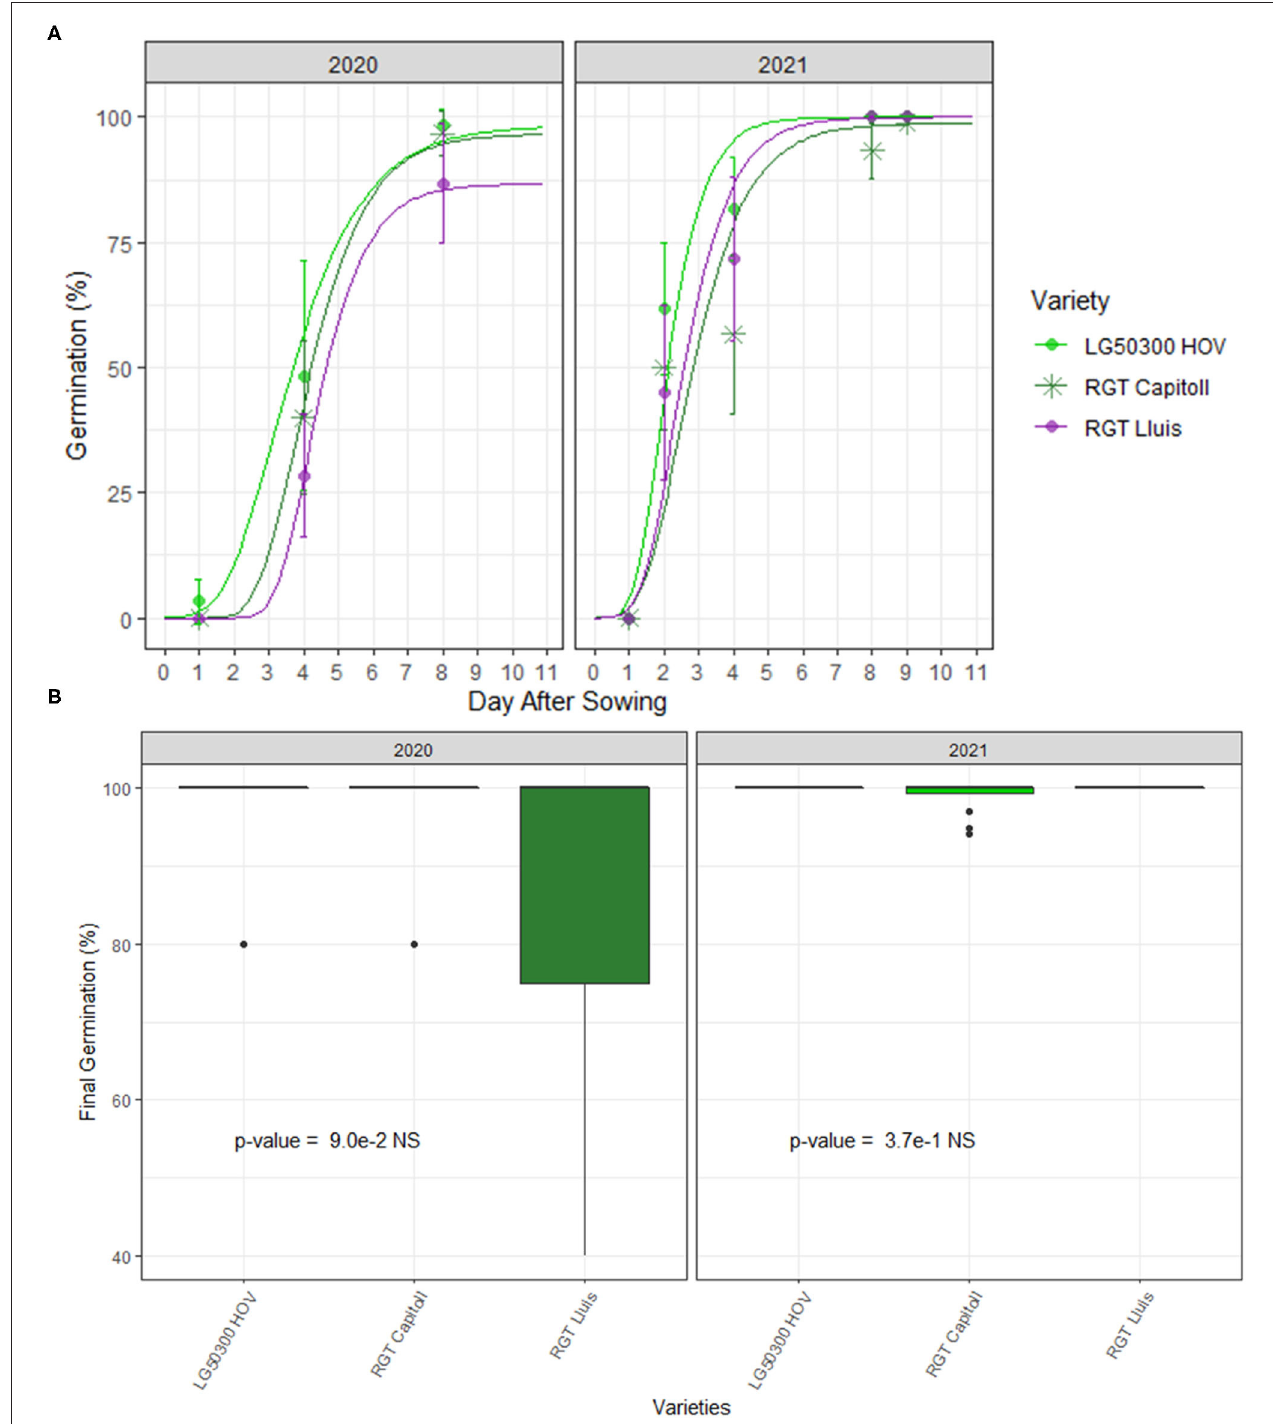
FIGURE 5 | Mean seed germination dynamics (A) and final rates (B) of three hybrid oilseed varieties of sunflower over the two experimental years, 2020 and 2021 at the Auzeville experimental station. Vertical bars reported in the figure represent confidence intervals. to abiotic stresses, water stress in the seedbed represents a severe (Aubertot et al., 2020; Lamichhane, 2021a). This study constraint for sunflower establishment in years like 2020, which demonstrated that both abiotic and biotic factors affect was characterized by almost no rainfall just before or after these sub-phases of sunflower establishment. More specifically